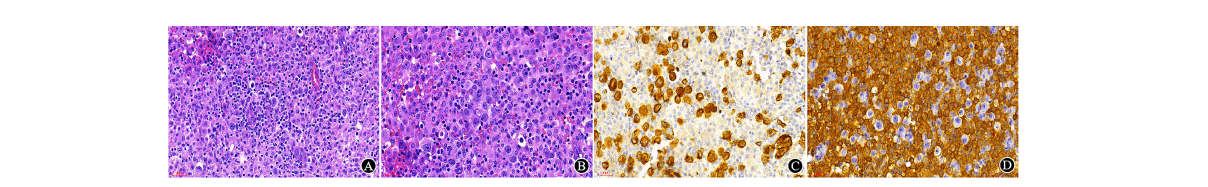
FIGURE 7 Misdiagnosed metastatic carcinoma. (A, B) In HE sections, there was signi fi cant histiocytic proliferation, atypical cells with large nuclei, and unremarkable epithelioid structure (A ×200, B ×300); (C) CKpan staining was positive in tumor cells (×300); (D) CD163 staining was positive in histiocytes